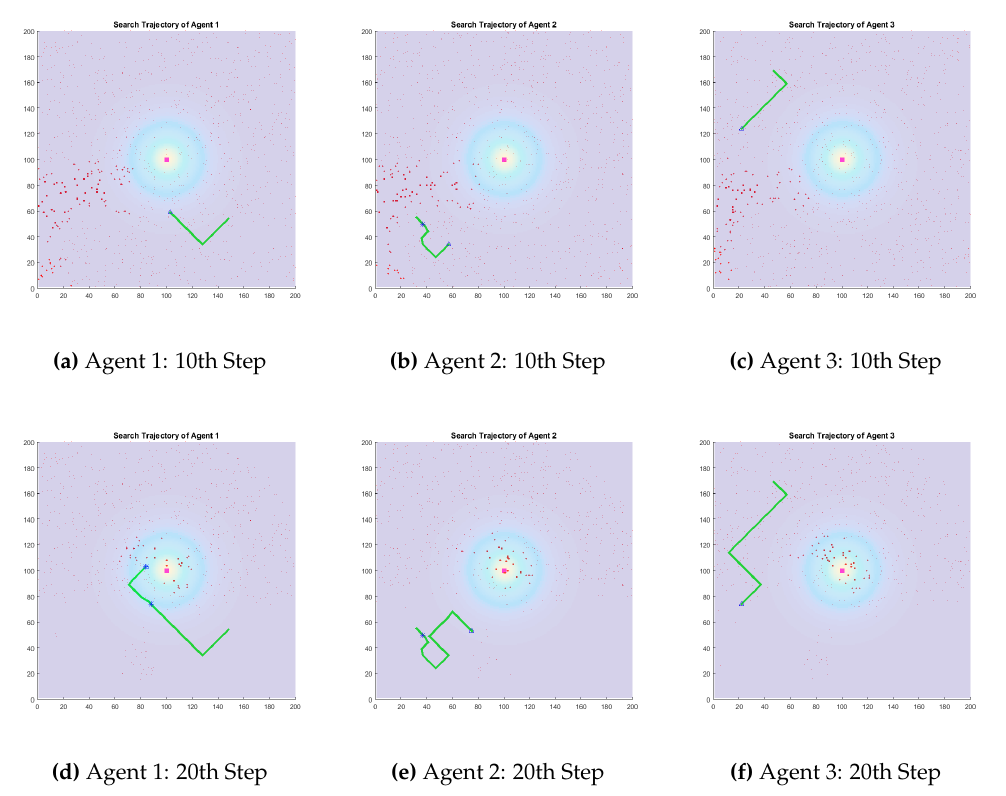
Figure 7. Search trajectory for a group of three robots searching for a source of chemical dispersion (( a ) Agent 1; ( b ) Agent 2; ( c ) Agent 3). The sensing capability of the robot is assumed to be independent of the bearing of the robot, then the uncertainty in direction of the robots is not included in the estimation process. The probability field is spanned by 300 Gaussian functions, which in this pictures are shown by a particles. Size of the particles does represent the associated weight of the particle. Each robot builds a probability distribution over the position of the source individually. At each step of time, every robot propagates the event it experiences. The other robots calculate the value of information encapsulate in that event and decide whether or not they contribute that sensor event to its estimation. The probability distribution for Robot 1 is pictured in 3D in Figure